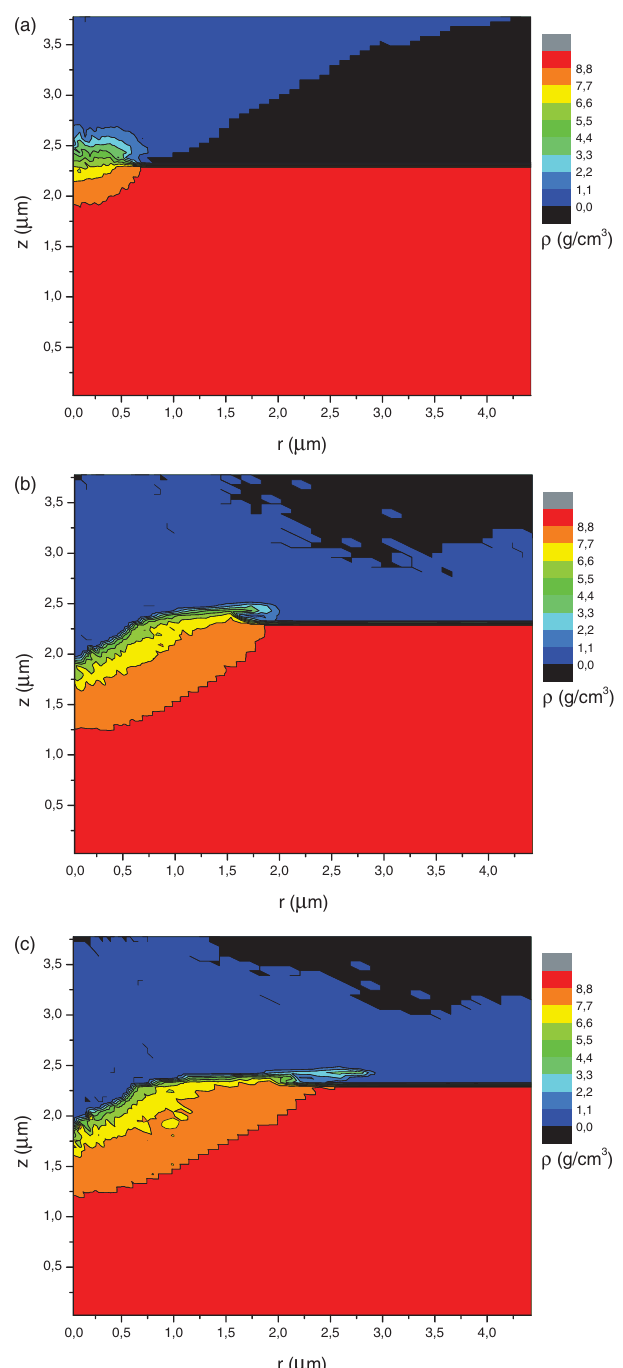
FIG. 5. Material density distribution at t ¼ 3 (a), 5 (b), and 10 ns ( с